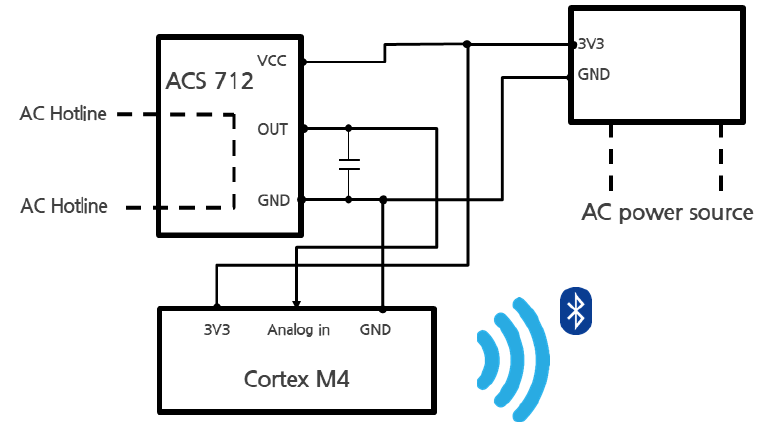
Figure 13. Hardware block diagram of Current Sensing Tag.